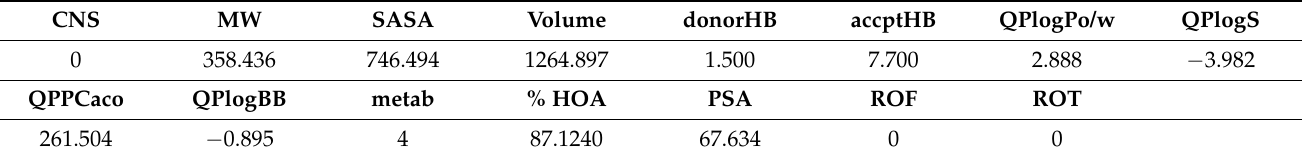
Table 2. Predicted ADME and molecular properties for compound 4